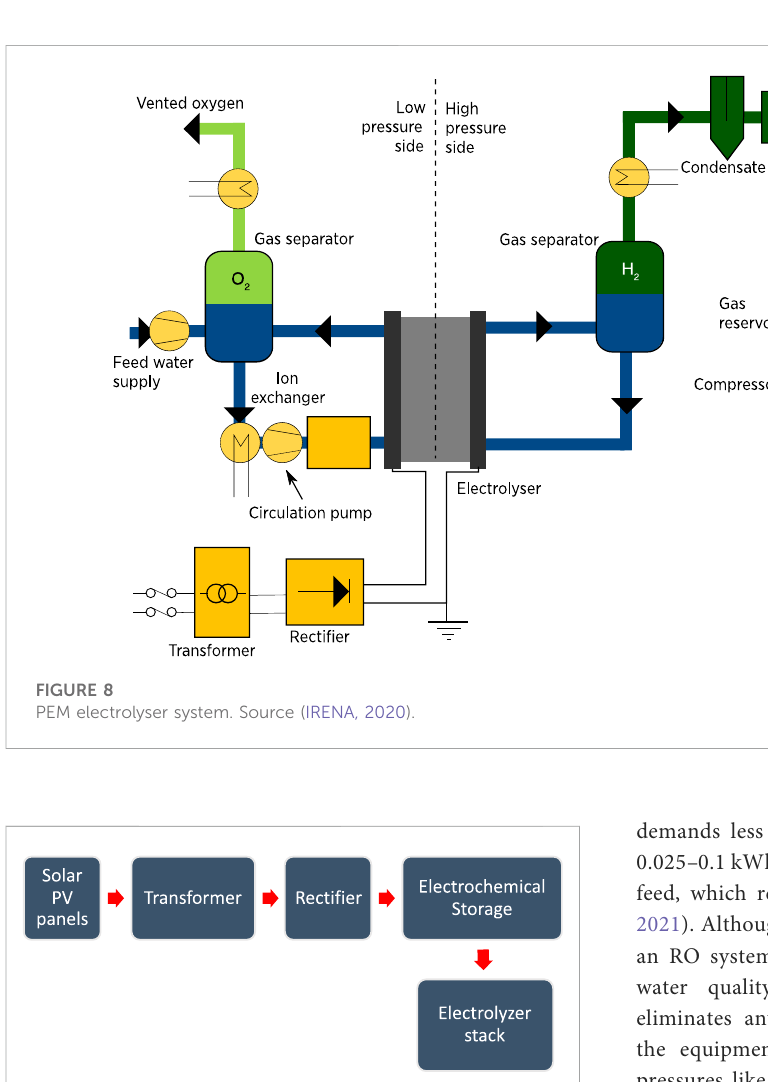
FIGURE 9 Power supply system for electrolyzer